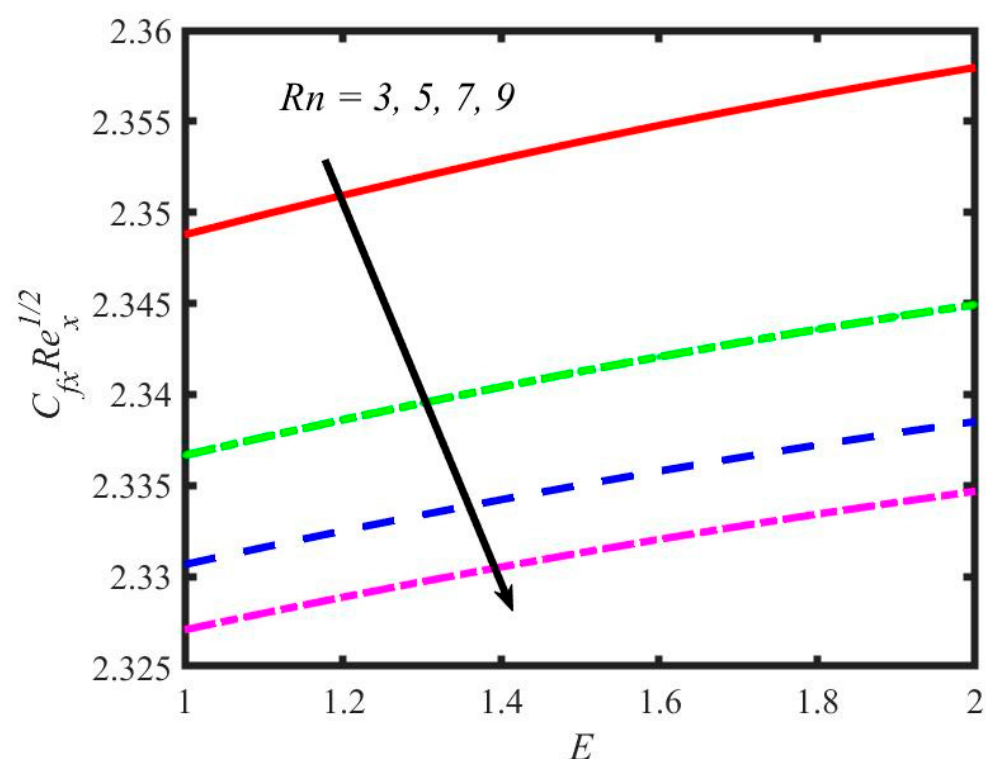
Figure 26. Variations in skin friction coefficient for radiation parameter.